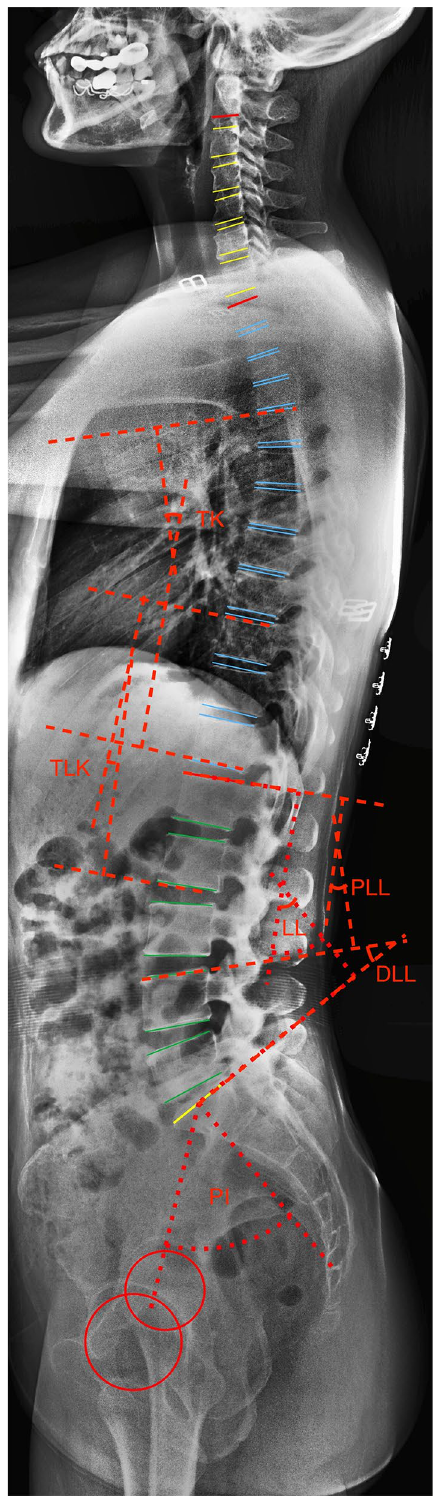
Figure 1. The graph shows the measurement of the sagittal spinopelvic alignments. PI pelvic incidence, LL lumbar lordosis (L1–S1), PLL proximal lumbar lordosis (L1–L4 superior endplate), DLL distal lumbar lordosis (L4 superior endplate to S1), TLK thoracolumbar kyphosis (T10–L2), TK thoracic kyphosis